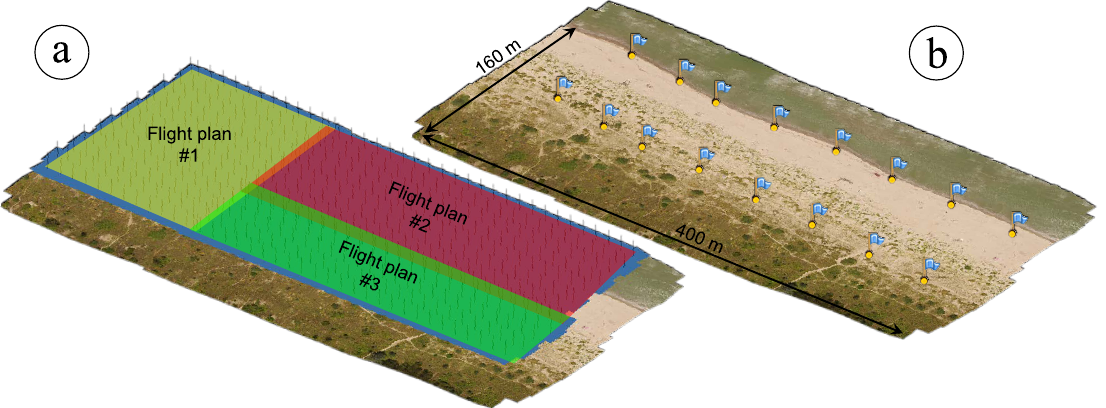
Figure 4. ( a ) Different flight plans’ coverage with overlap for including all the study area; ( b ) Ground Control Points location and extent of the